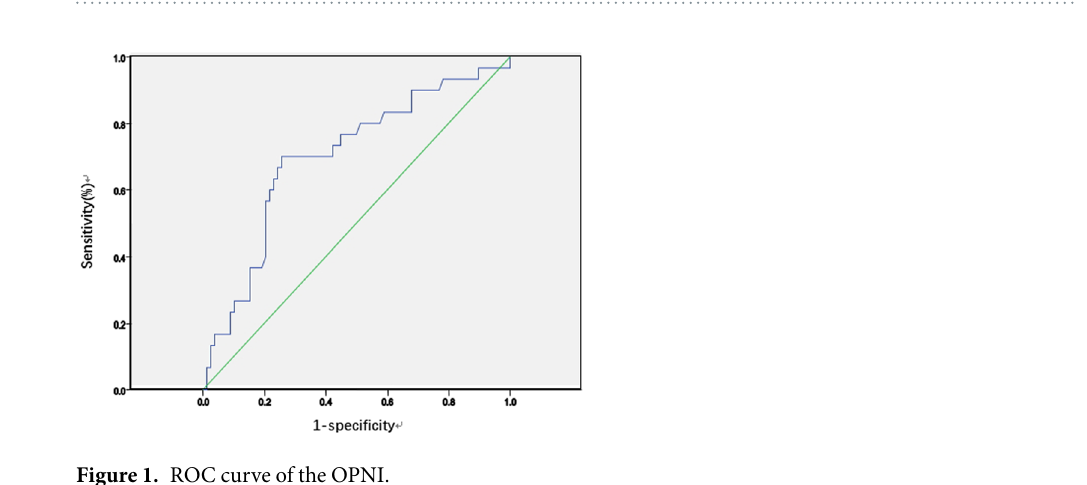
Figure 1. ROC curve of the